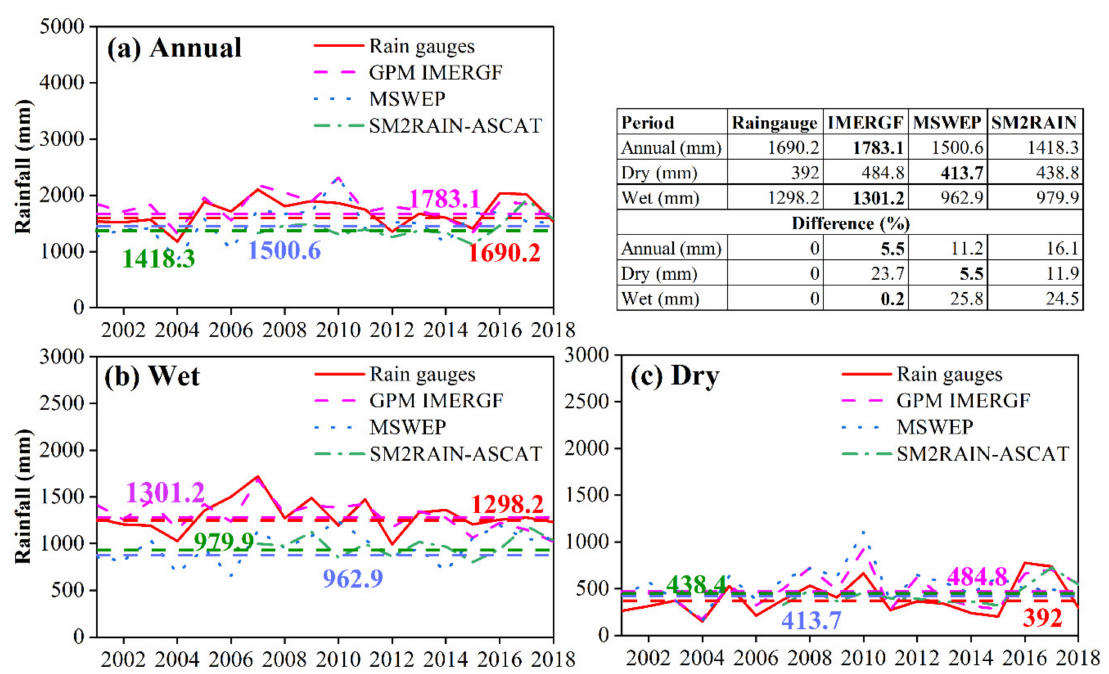
Figure 4. Annual, dry, and wet rainfall seasons for ( a ) IMERGF-V6, ( b ) MSWEP, and ( c ) SM2RAIN– ASCAT. Bold values indicated the best score. Dash lines with the corresponding colors represent the mean values of rainfall estimates for each